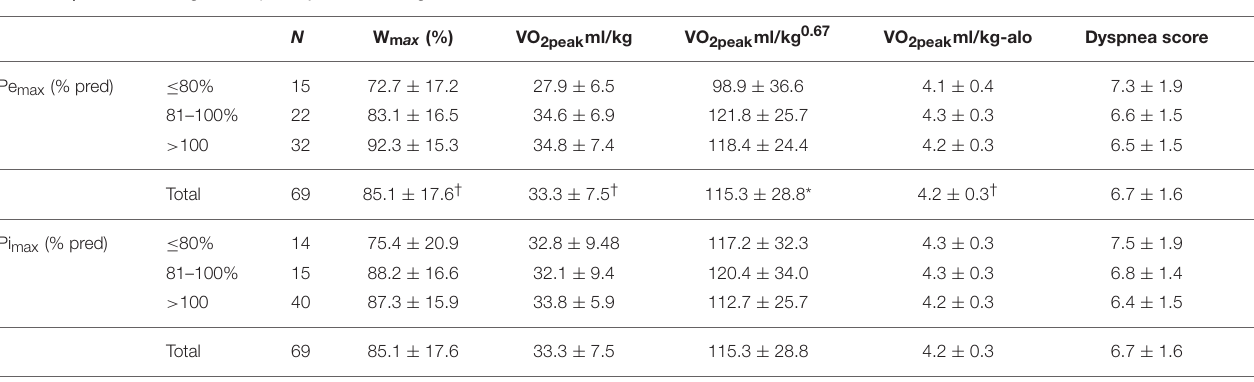
TABLE 2 | Exercise testing and respiratory muscle